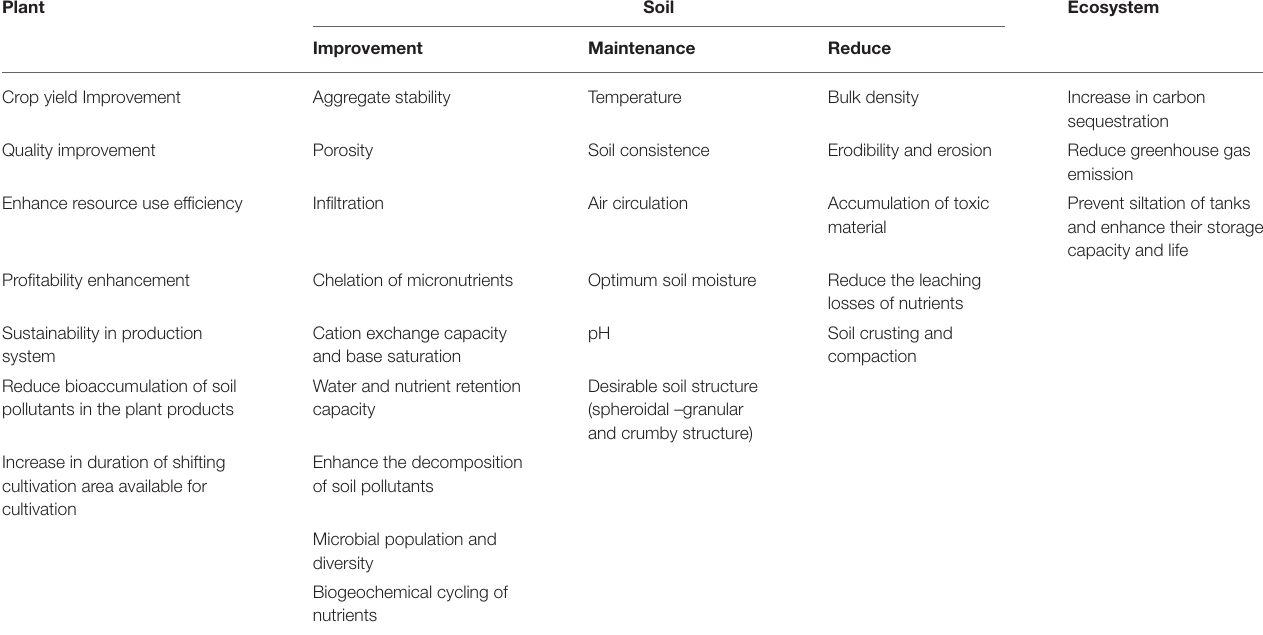
TABLE 6 | Functions of soil organic carbon. Plant